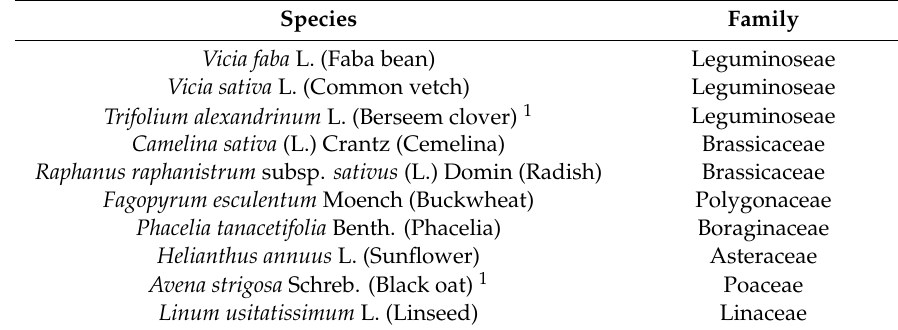
Table 4. Cover crop species (species name and family) characterized by rhizobox experiments and Root Atlas